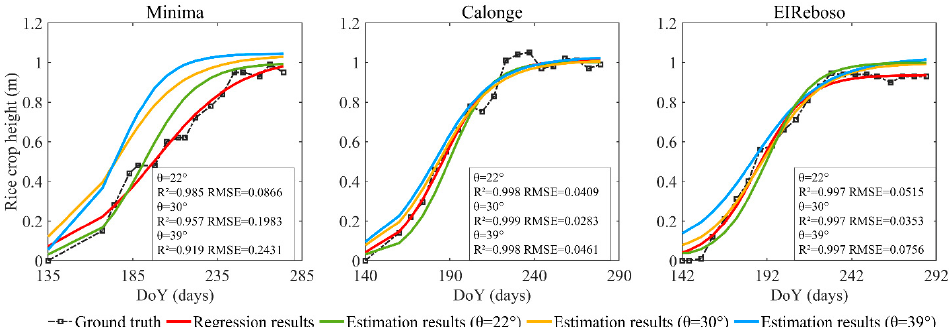
Figure 12. Comparison of the model inversion performance and the ground-truth regression results. The rice height predictions obtained from the proposed approach with a 22° incidence angle (green), 30° incidence angle (yellow), and 39° incidence angle (blue) are compared with the line obtained by nonlinear fitting directly using the ground-truth values (orange). The statistics are listed in the lower right corner of each figure.